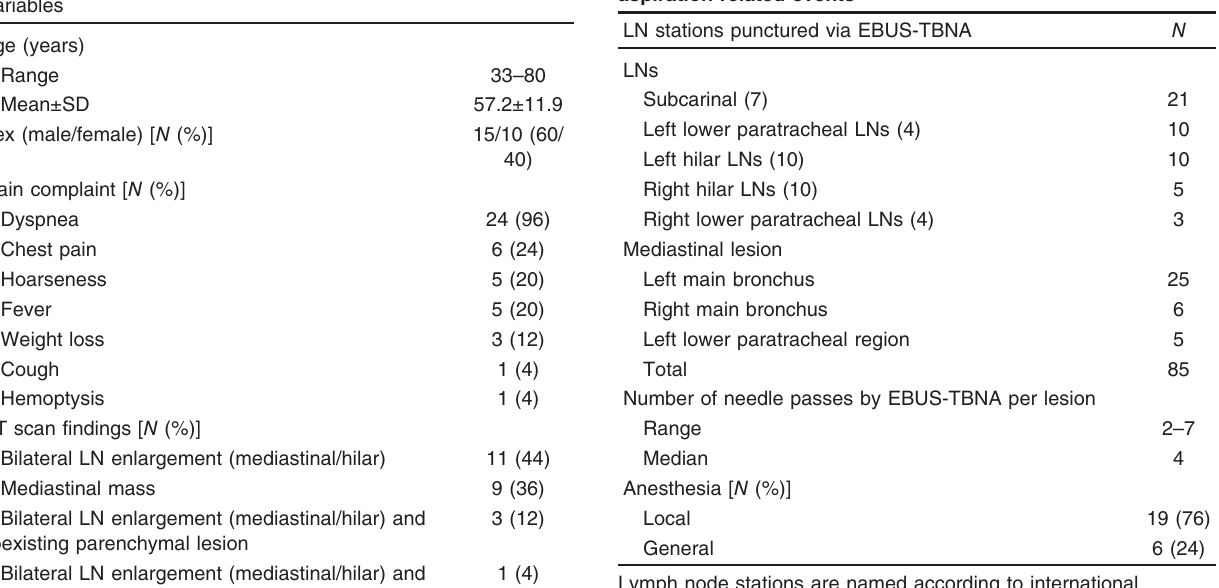
Table 2 Endobronchial ultrasound-transbronchial needle aspiration-related events